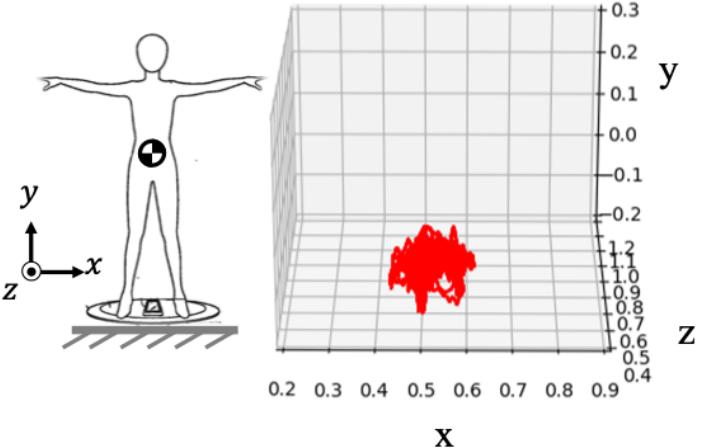
Figure 10. The results of trajectories of the center of gravity (COG) when the human subject stands on the wobble